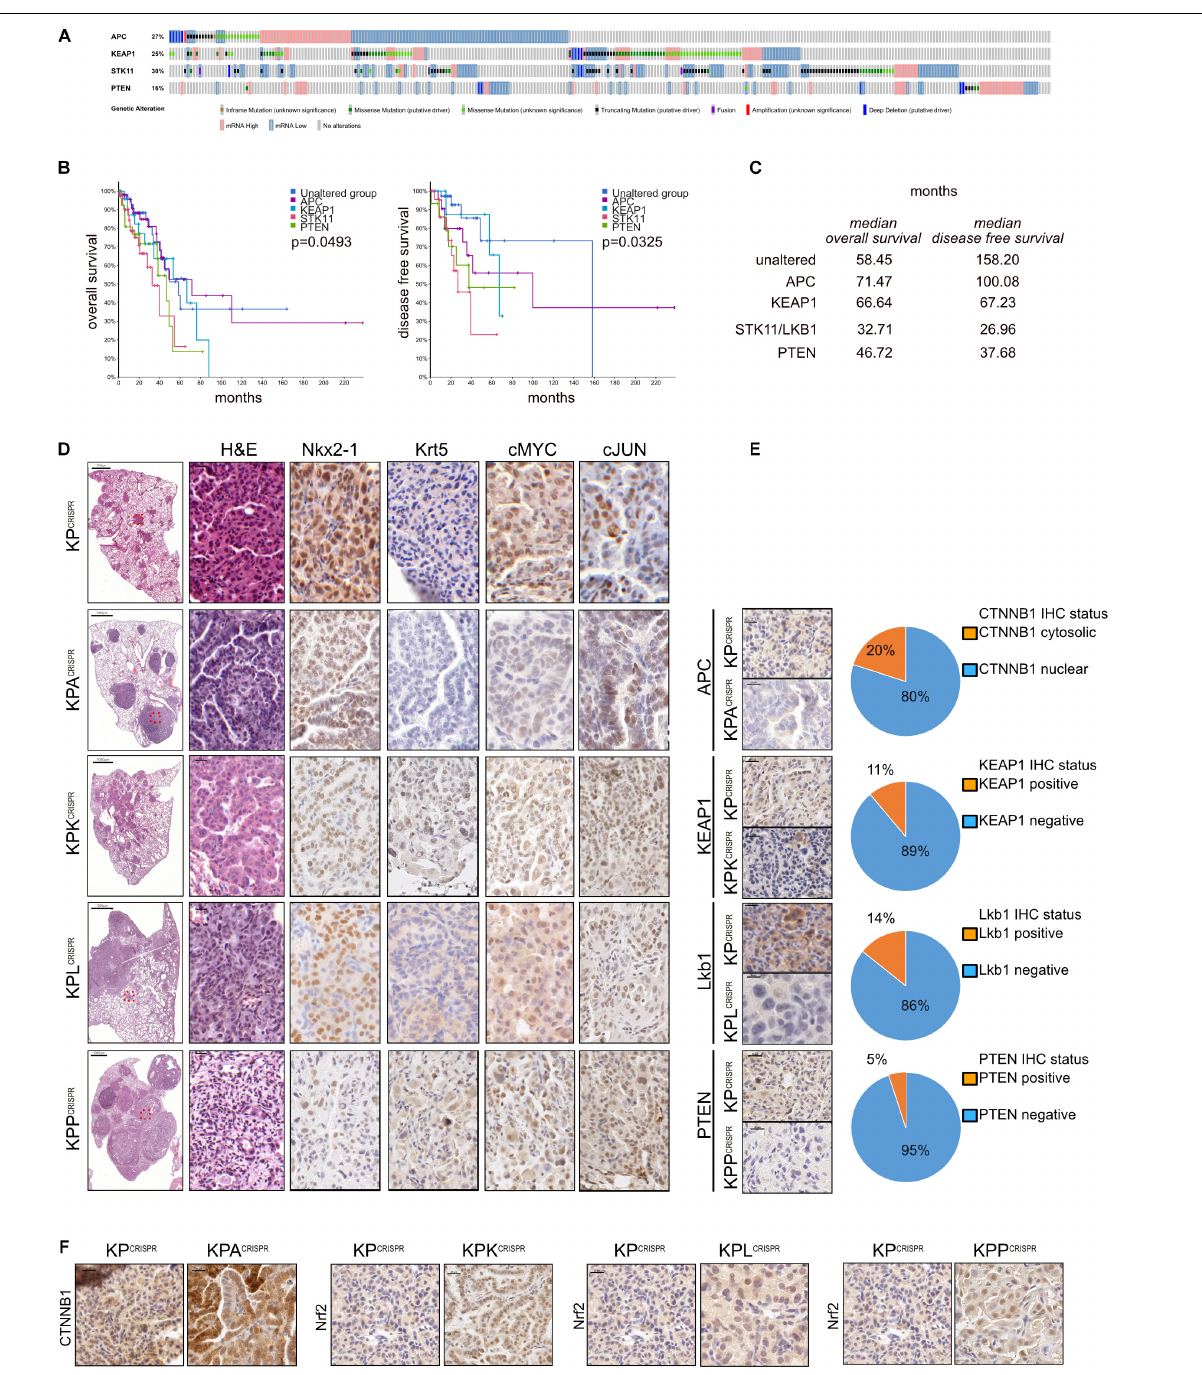
Frontiers in Cell and Developmental Biology |